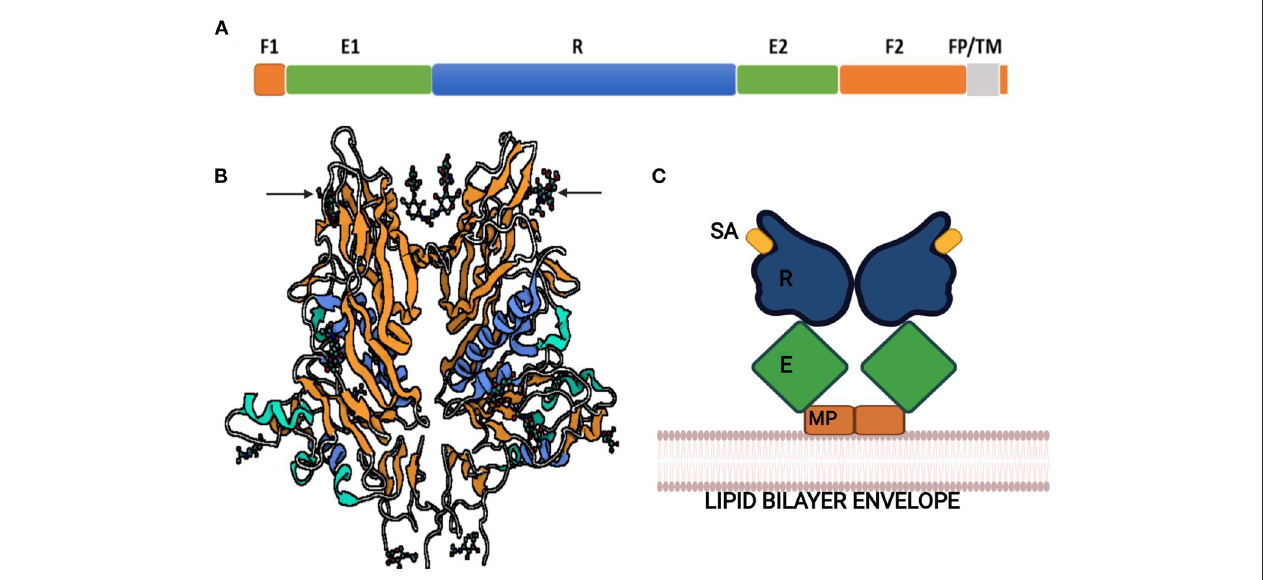
FIGURE 5 | Hemagglutinin-esterase protein of bovine coronavirus. (A) Linear order of sequence segments HE protein. F1 and F2, Fusion domains; E1 and E2, Enzyme domains; R, Receptor domain; FP, Fusion peptide; TM, Transmembrane domain. (B) Ribbon representation of HE protein. Lectin domain in orange, esterase domain in blue, and structures shown by arrows are sialic acids (sialic acid-9-O-acetylesterase) bound to lectin domain. (C) Schematic illustration of HE dimer. SA, Sialic acid; R, Receptor domain; E, Enzyme domain; MP, Membrane-proximal domain.